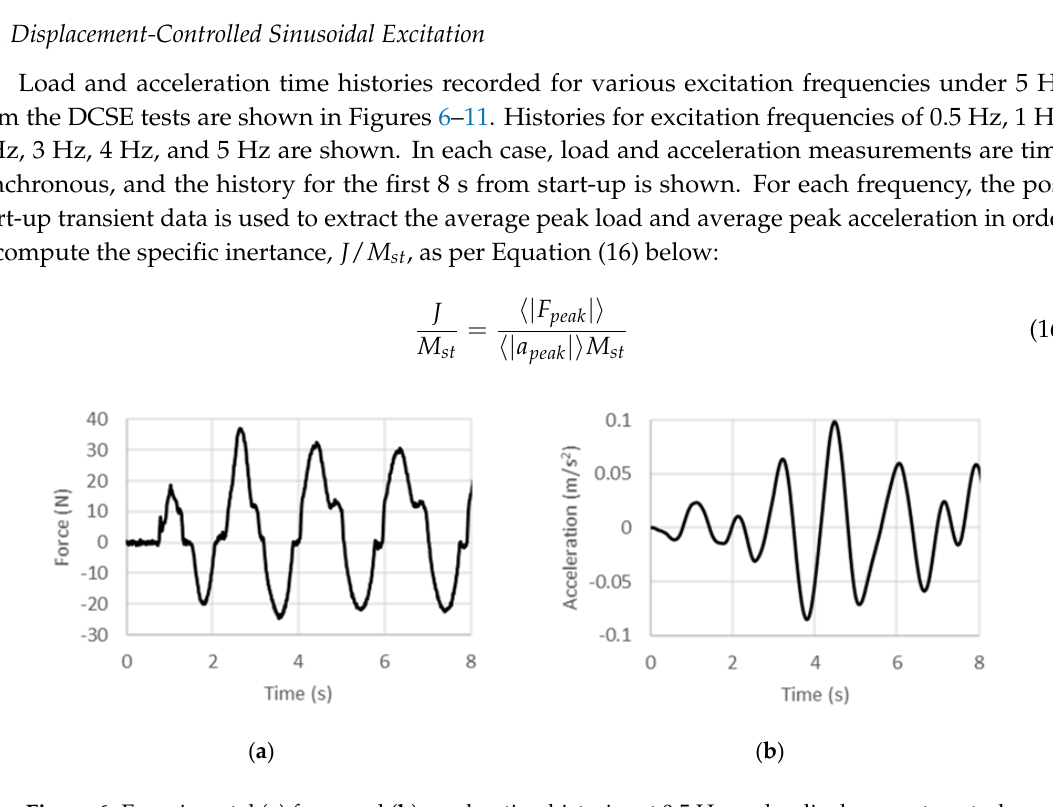
Figure 6. Experimental ( a ) force and ( b ) acceleration histories at 0.5 Hz under displacement control.